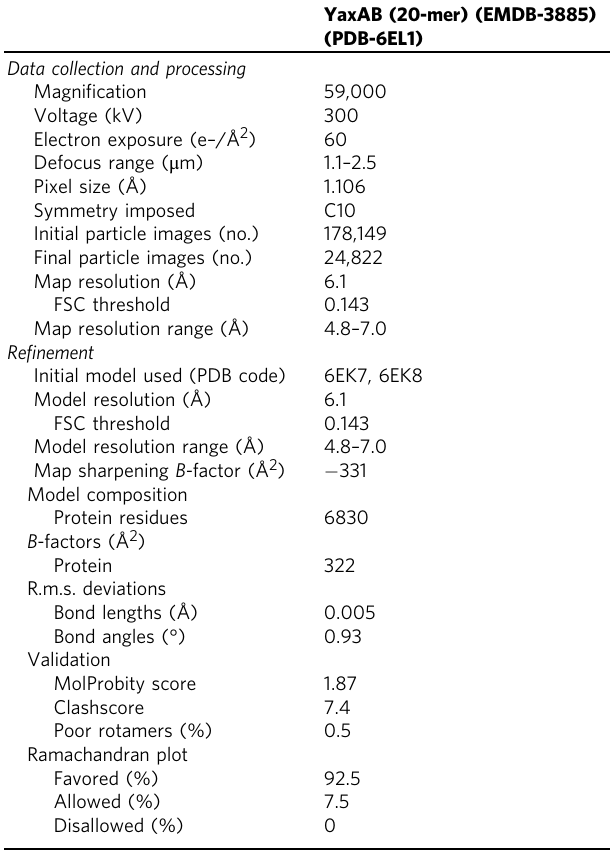
Table 2 Cryo-EM data collection, re fi nement, and validation